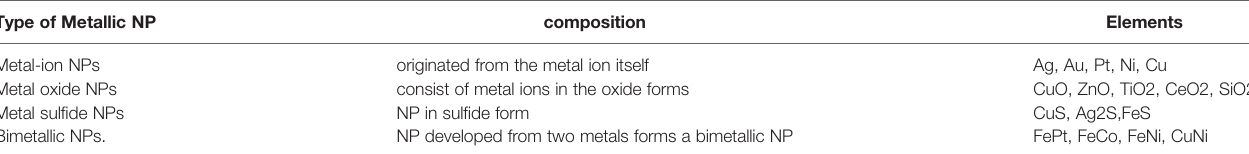
TABLE 4 | Showing different types of metallic nanoparticles (MNPs) and their